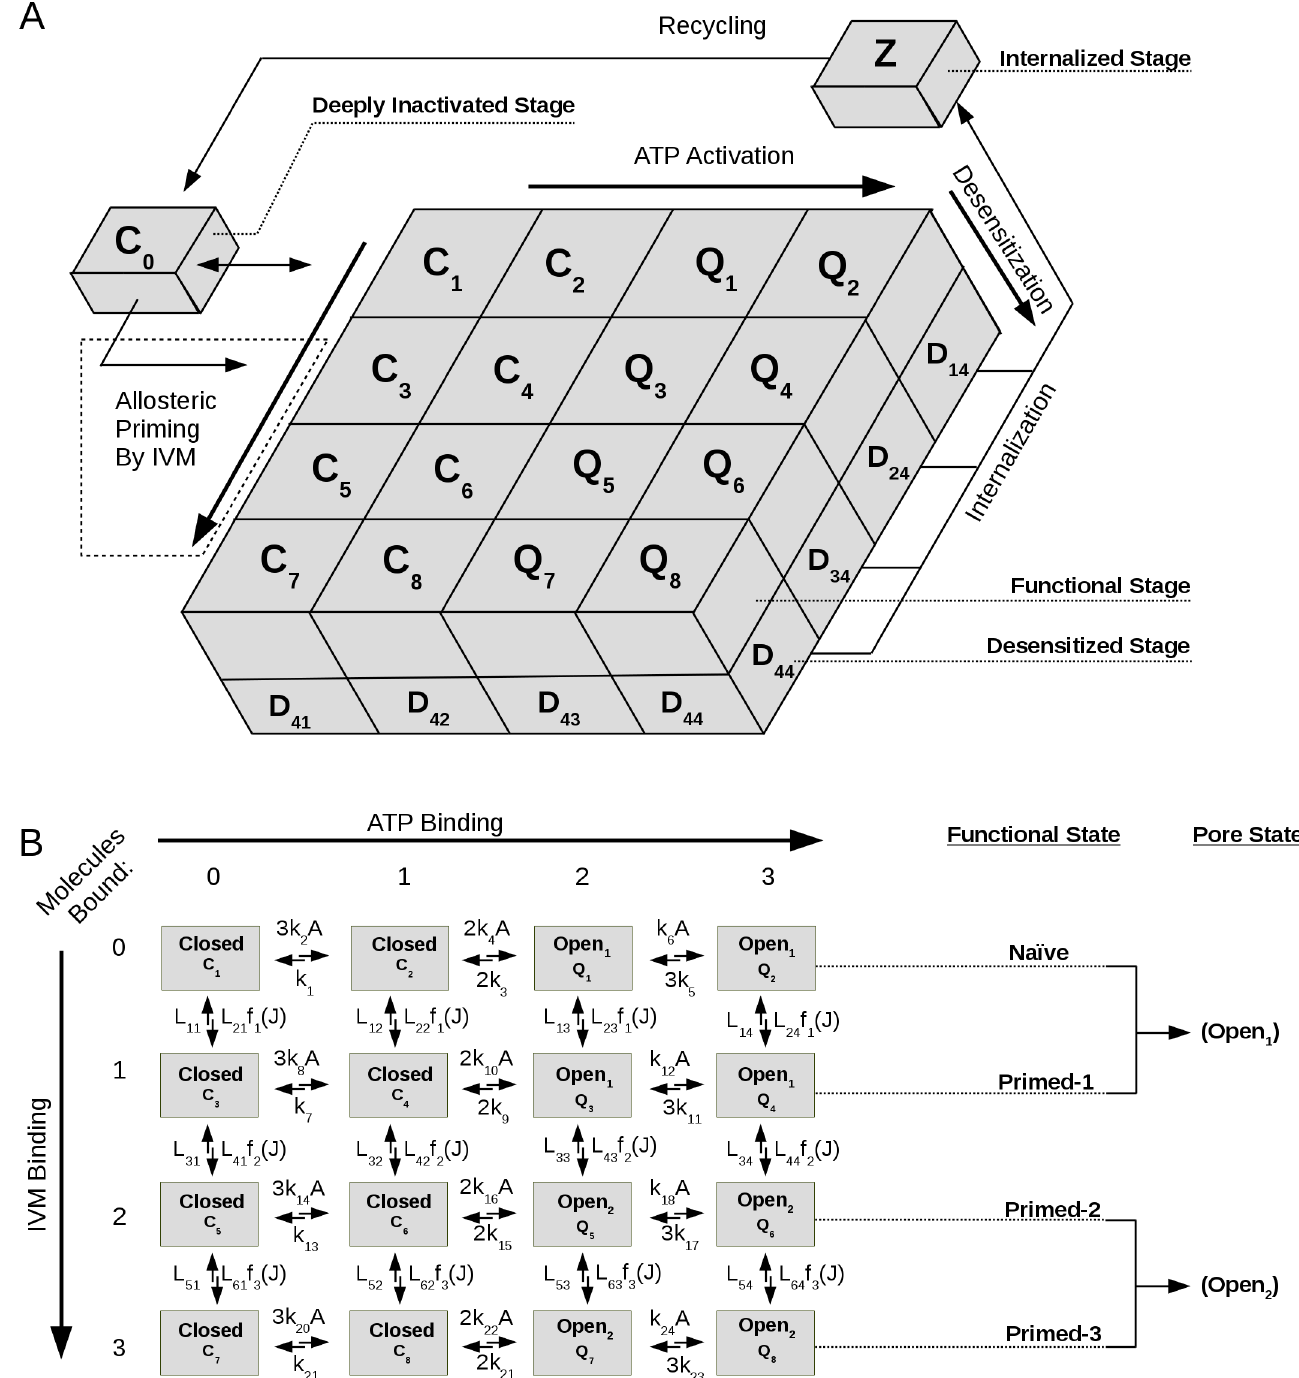
Fig 3. Diagram of the two-layer Markov state model describing the sequential binding and unbinding of ATP (denoted by A ) and IVM (denoted by J ) to P2X4R. (A) The activationcycle of P2X4R channels.In the two-layermodel, receptors exist in four different stages: functional, desensitized, internalized,and deeply inactivated.The upper layer represents the functionalstage of receptors, with closed, C i , and conducting, Q i , states, i = 1, 2, (cid:1)(cid:1)(cid:1) , 8, and a lower layer represents the nonconducting desensitizedstage comprisedof D jk states, j , k = 1, 2, 3, 4. Two additionalstages, Z and C 0 , representsinternalizedand deeply inactivated states, respectively.(B) The occupancy of orthostericand allosteric bindingsites and the pore states of receptors in functionalstage. Transitionsbetweenstates along rows represent binding(rightward)or unbinding(leftward) of one ATP, and along columns represent binding(downward) or unbinding(upward)of one IVM. Receptorsare in na ï veor primedfunctionalstates, and receptors are